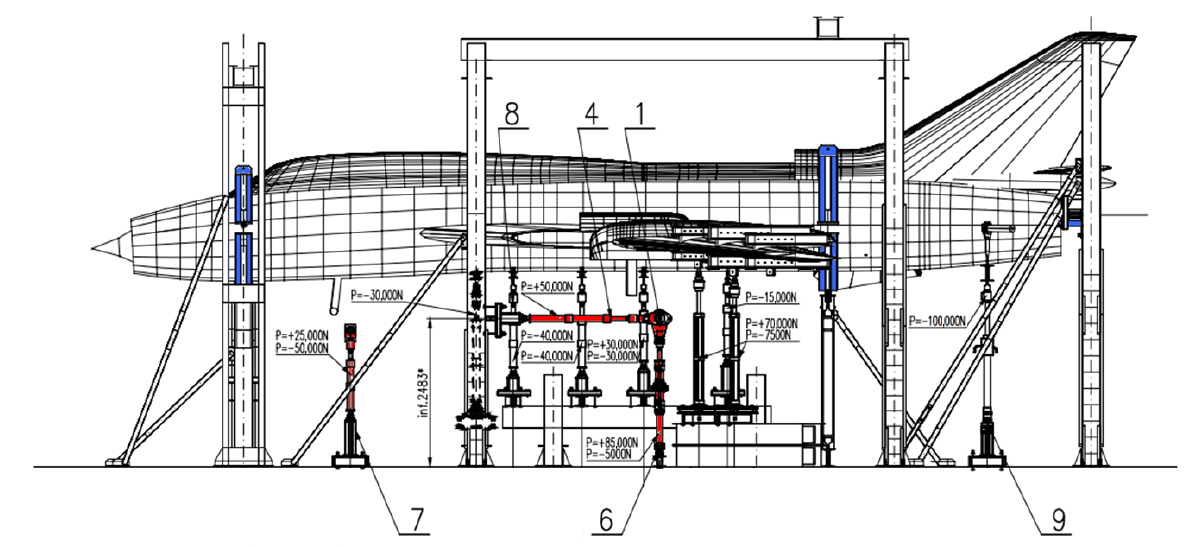
Figure 2. Configuration of actuators for Stage I of Full-Scale Fatigue Test execution.